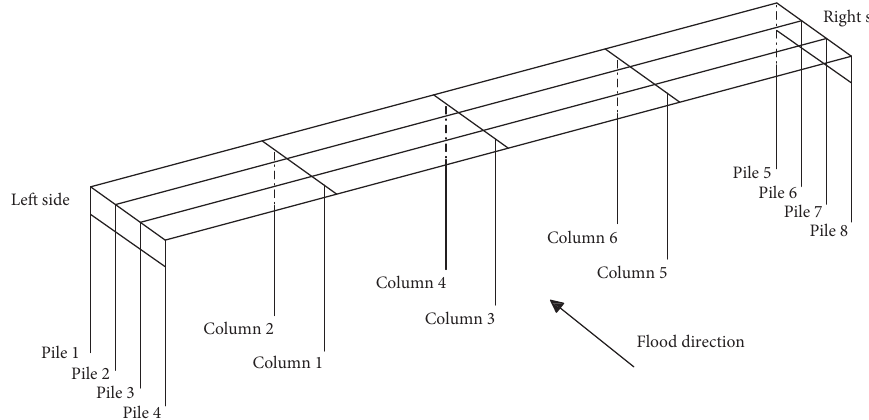
Figure 30: Simplified structure of Shangban